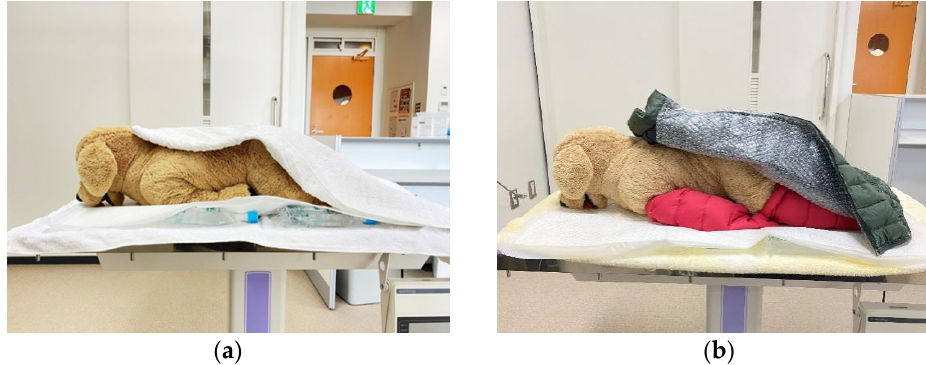
Figure 2. Model of the control group and the heat insulating group undergoing an MRI exam. ( a ) the control group, the animal was covered with a bath towel. ( b ) the heat insulating group, the animal was covered with bubble wrap and down cloth blanket. Both dogs were placed on hot water bottles with sheets between them.